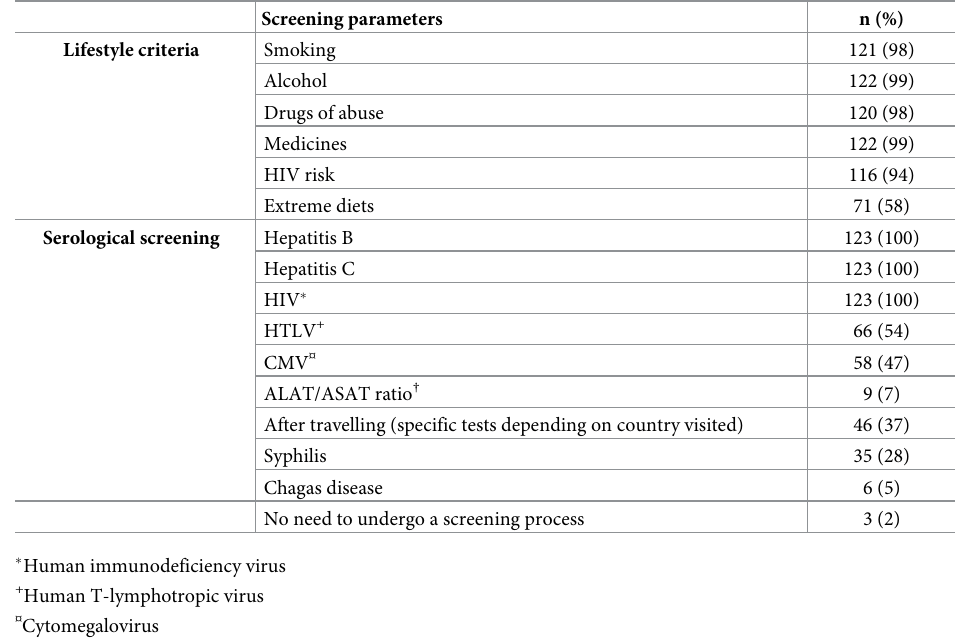
Table 1. Parameters included in the donor screening processes of European HMBs (n =